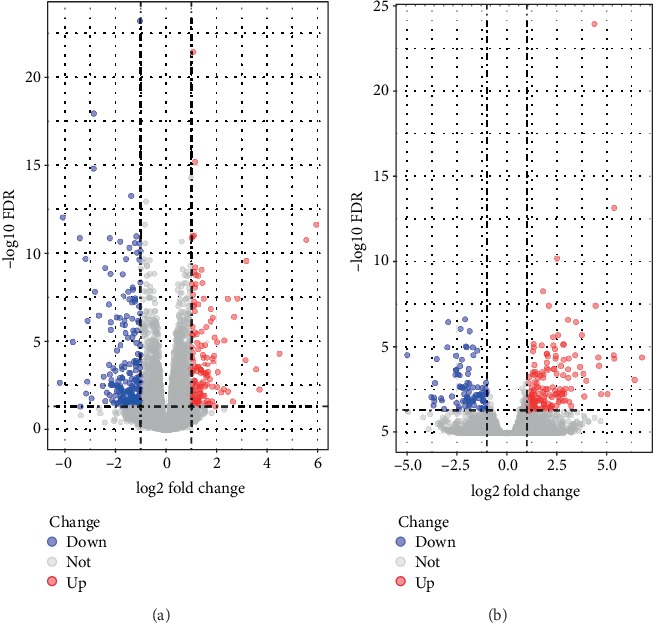
The volcano plot of significant DEmRNAs in GSE104674 (a) and GSE133099 (b). Red dots represent upregulated mRNAs, and blue dots represent downregulated mRNAs.